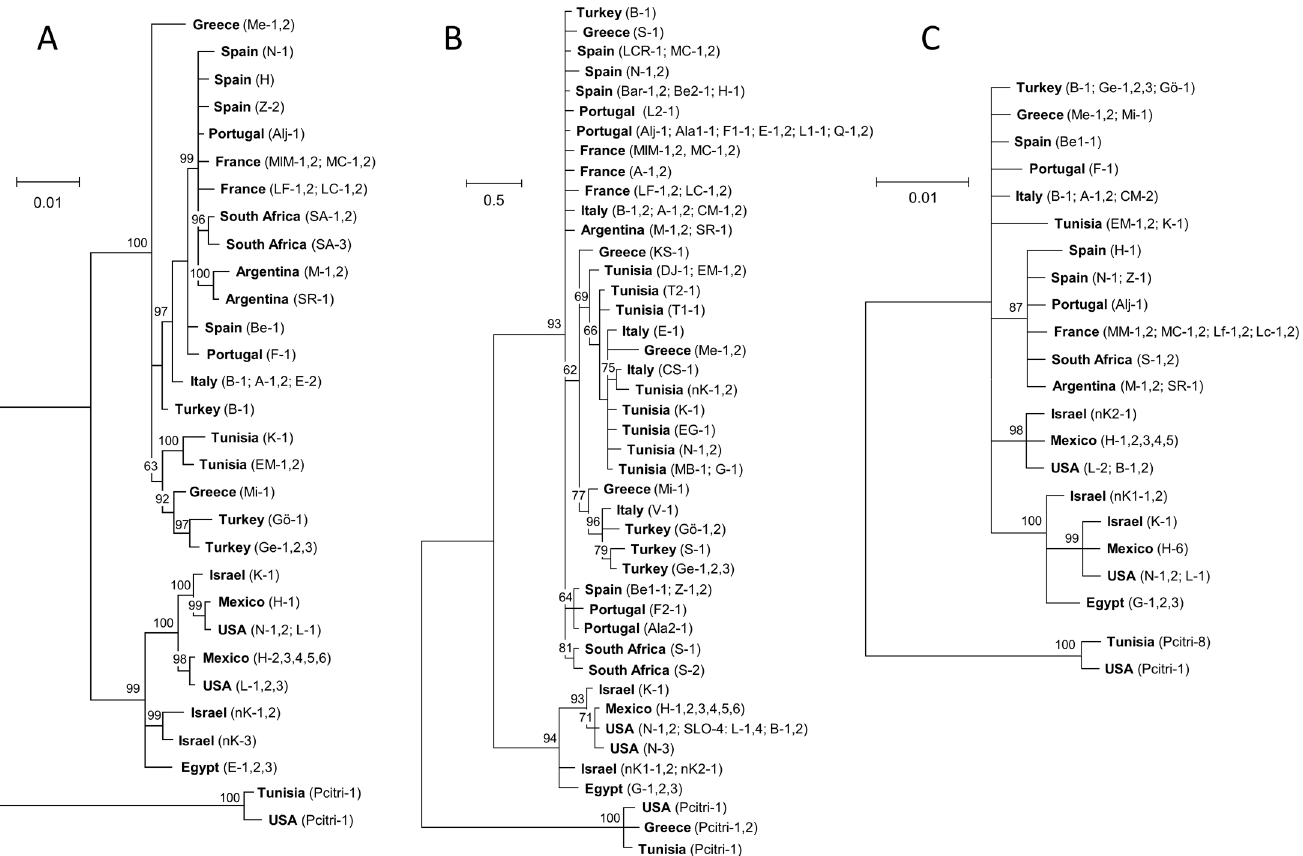
Fig 1. (A) Consensus trees for populations of Planococcus ficus (and the out-group Pl . citri ) derived from Bayesian analysis, with the numbers at nodes showing posterior probabilities, using (A) a concatenated CO1 and ITS1 data set, (B) the COI data set, and (C) the ITS1 data set; the insect populations were collected in Europe, Africa, the Middle East, Argentina, California and Mexico and presented grouped by the nearest city and the isolate tested (codes are in Supplemental Table